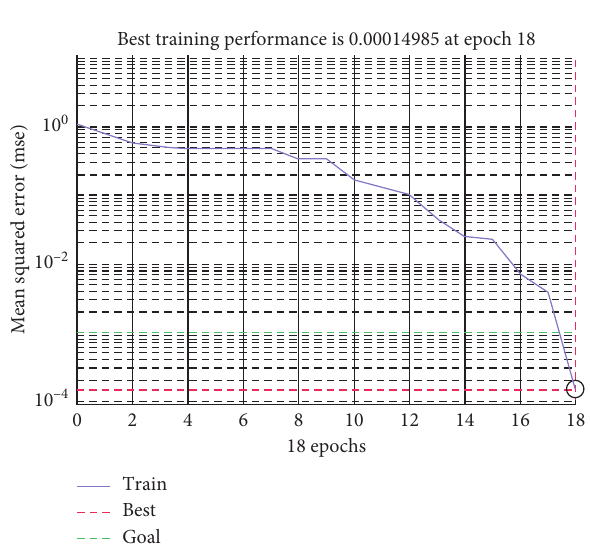
Figure 18: Performance curve of the network (trainbfg training